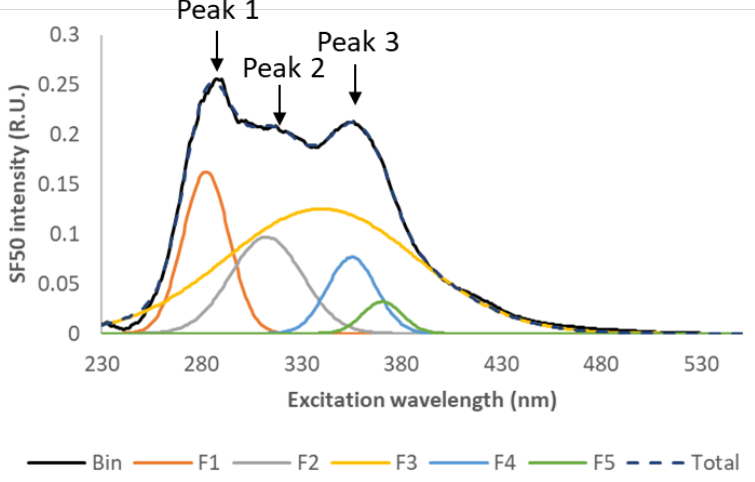
Figure 6. Synchronous fluorescence spectrum for B1in (sampling date: 16 June 2020).